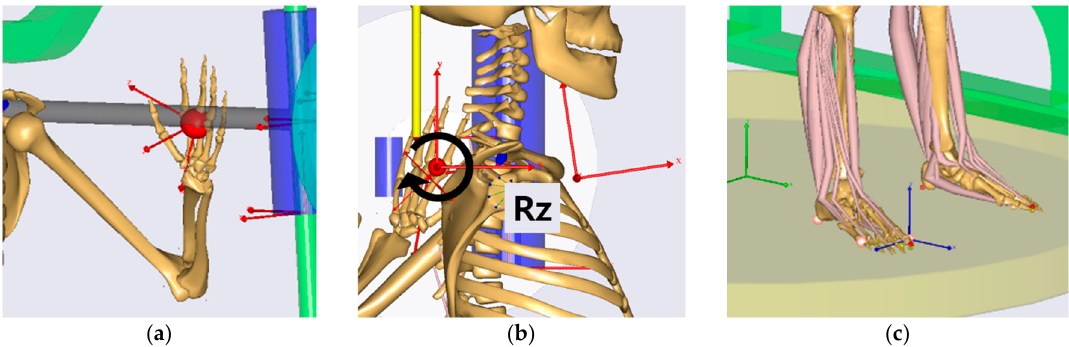
Figure 5. Modeling of interaction among a human, machine, and environment: ( a ) weld joints to fix hands on barbell; ( b ) revolute joints to model contact of barbell bar with shoulder area; and ( c ) weld joints to fix feet on ground.